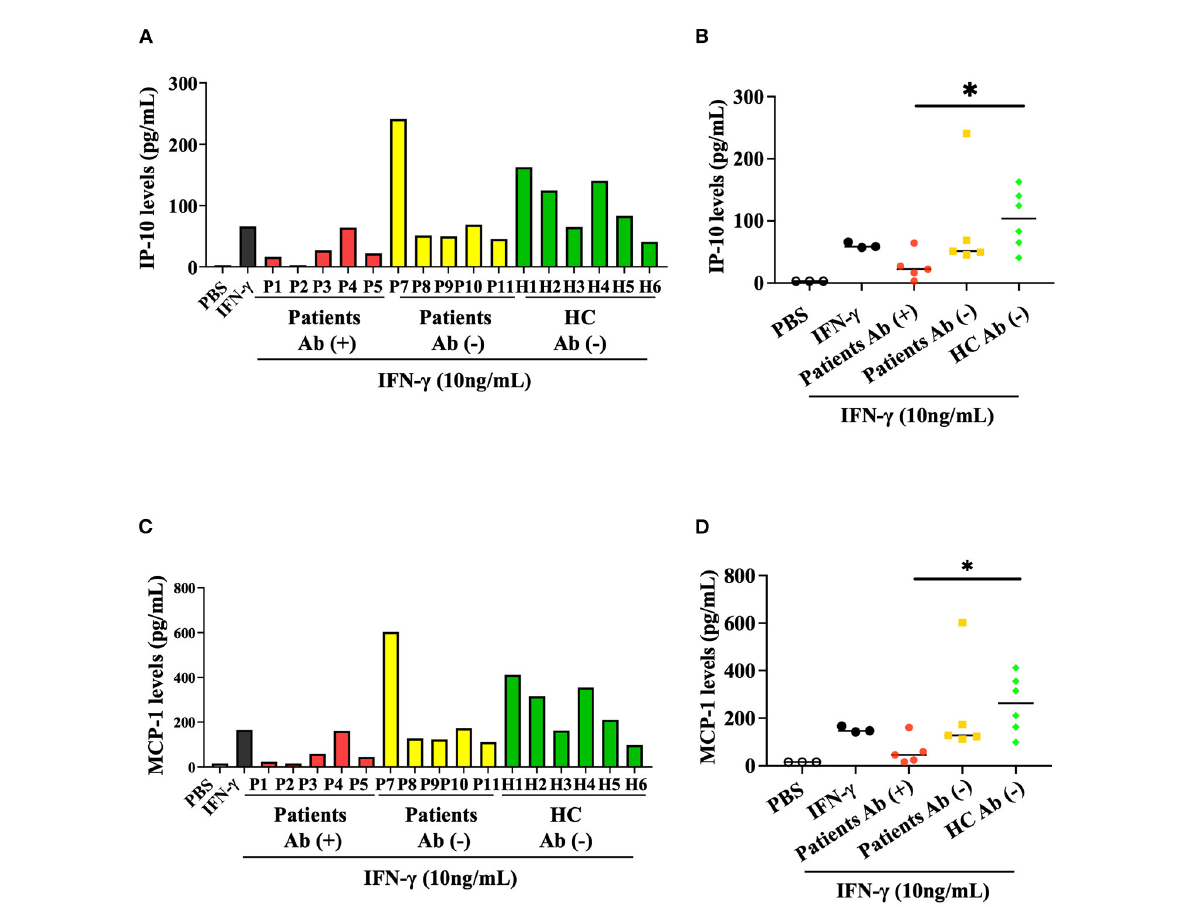
FIGURE3 Inhibitory effect of anti-IFN- γ autoAbs on IFN- γ -mediated chemokines. (A) The inhibitory effects of anti-IFN- γ autoAbs on IFN- γ -mediated IP-10 production in THP-1 cells treated with serum samples from autoAbs-positive AOSD patients (P1-P5), autoAbs-negative patients (P7-P11), or HC subjects (H1-H6). (B) Comparison of the supernatant levels of IP-10 on THP-1 cells treated with serum samples from three groups subjects. (C) The inhibitory effects of anti-IFN- γ autoAbs on IFN- γ -mediated MCP-1 production in THP-1 cells treated with serum samples from three group subjects. (D) Comparison of the supernatant levels of IP-10 on THP-1 cells treated with serum samples from three groups subjects. Data are presented as box-plot diagrams, with the box encompassing the 25 th percentile (lower bar) to the 75 th percentile (upper bar). The horizontal line within the box indicates median value for each group. * p < 0.05, vs. HC, determined by the Kruskal-Wallis test using a post-hoc Dunn’s test. IP-10, IFN- γ inducible protein-10; MCP-1, monocyte chemoattractant